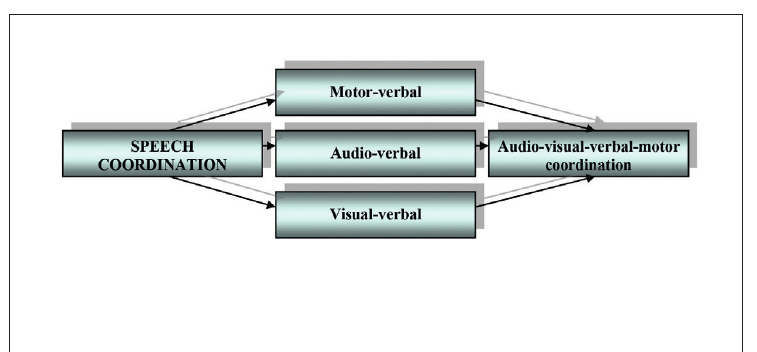
Figure 4. Types of speech coordination of a coach of the therapeutic gymnastics (Aftimichuk,